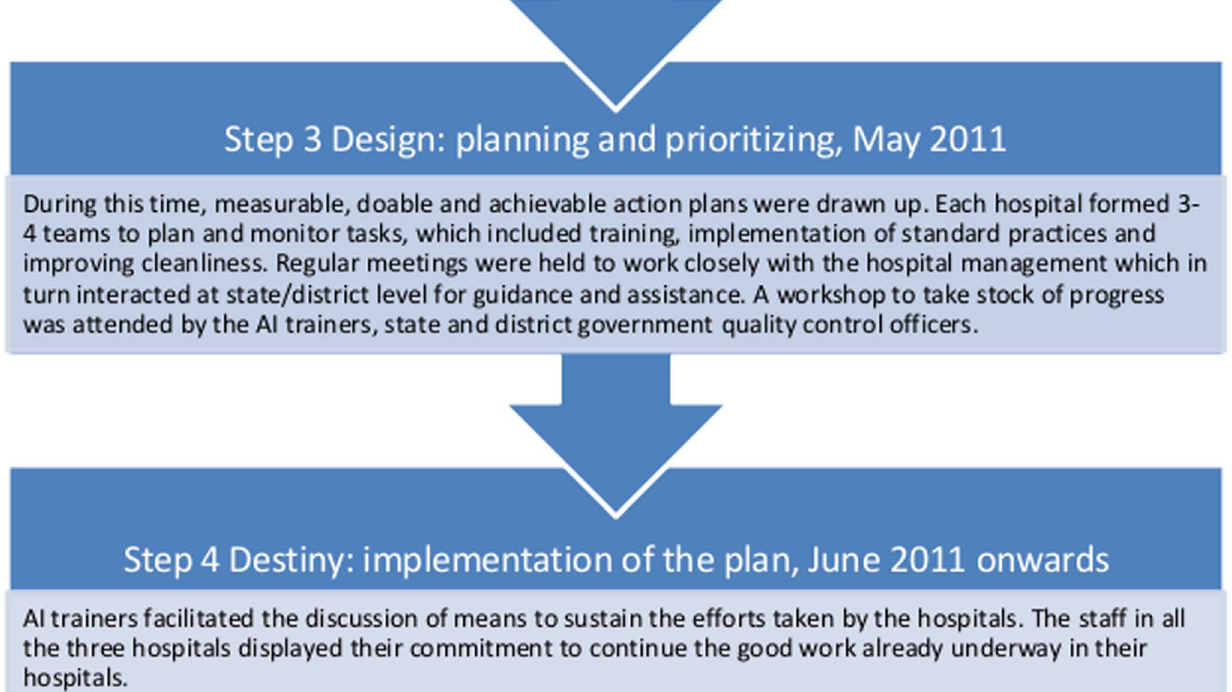
Figure 2. Appreciative inquiry, description of the study intervention and key events.